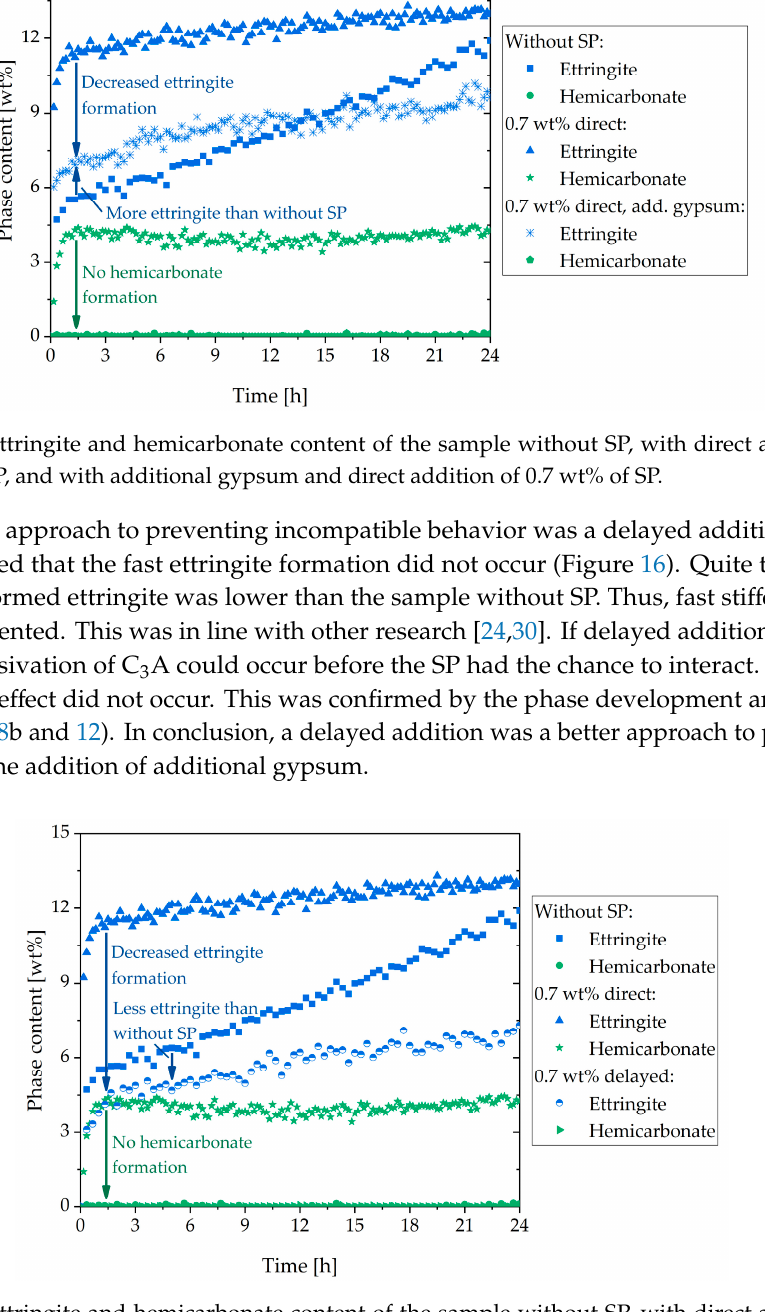
Figure 16. Ettringite and hemicarbonate content of the sample without SP, with direct addition of 0.7 wt% of SP, and with a delayed addition. 0.7 wt% of SP, and with a delayed